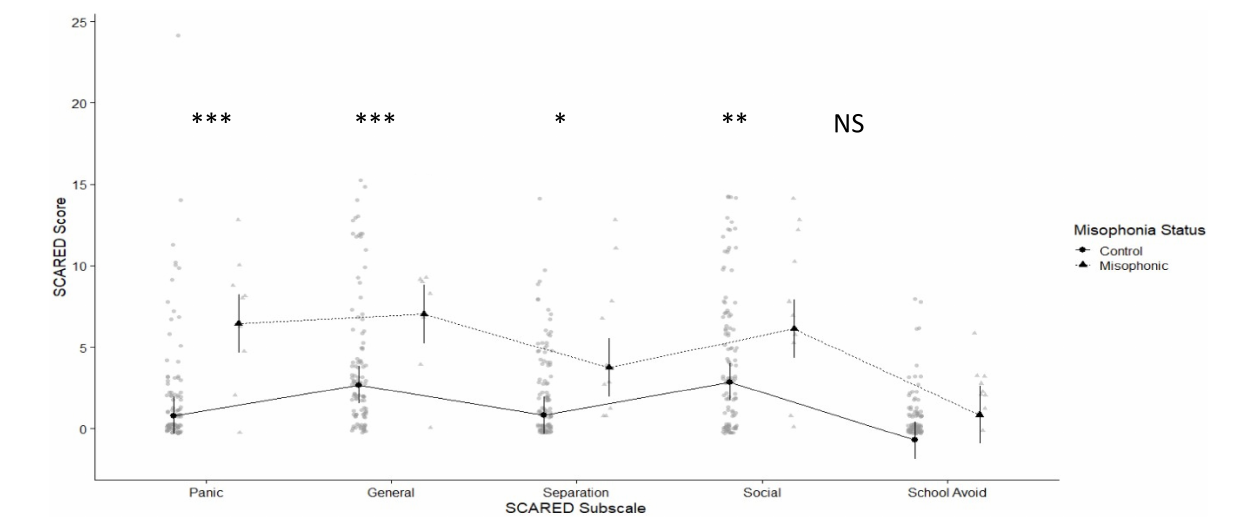
FIGURE 1 | Means plot showing differences between misophonics (shown in triangle) and controls (shown in circles) in each of the SCARED subscales (from left to right: Panic Disorder , General Anxiety , Separation Anxiety , Social Anxiety , and School Avoidance)